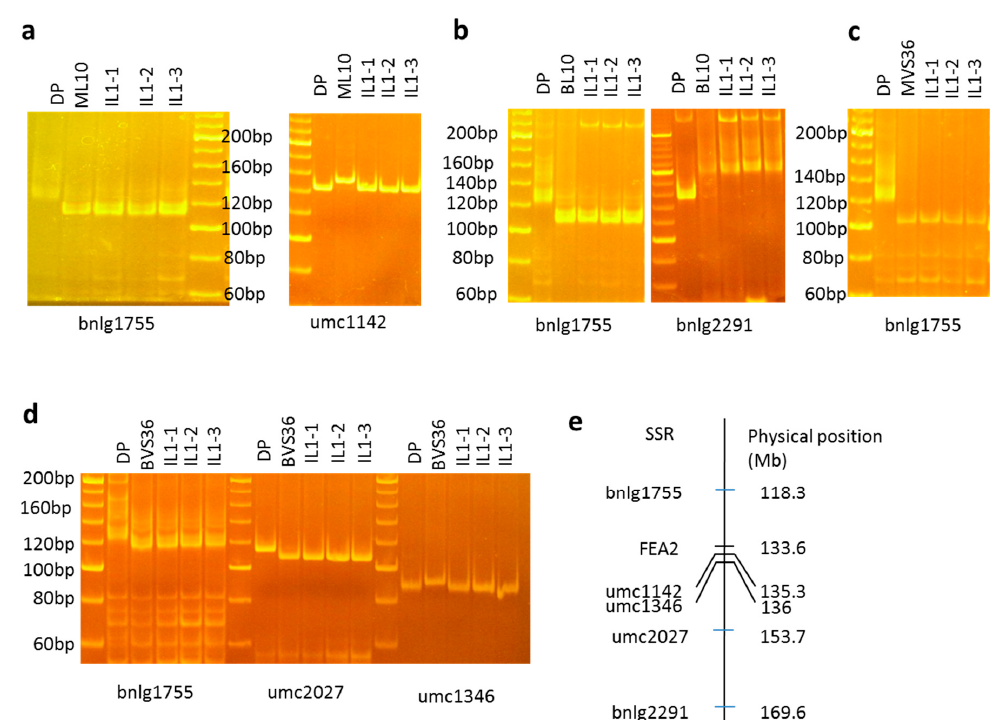
Figure 3. Analysis of the introgression region around the FEA2 loci. SSR (Simple Sequence Repeats) analysis using template DNAs from DP, RP, and corresponding ILs. IL1-1, IL-2, or IL-3 indicated pooled DNA from individuals of the BC 3 F 4 family 1, 2, or 3. ( a ) Polymorphic SSRs between DP and ML10. ( b ) Polymorphic SSRs between DP and BL10. ( c ) Polymorphic SSRs between DP and MVS36. ( d ) Polymorphic SSRs between DP and BVS36. Ladders are O’RangeRuler 20 bp DNA Ladders from